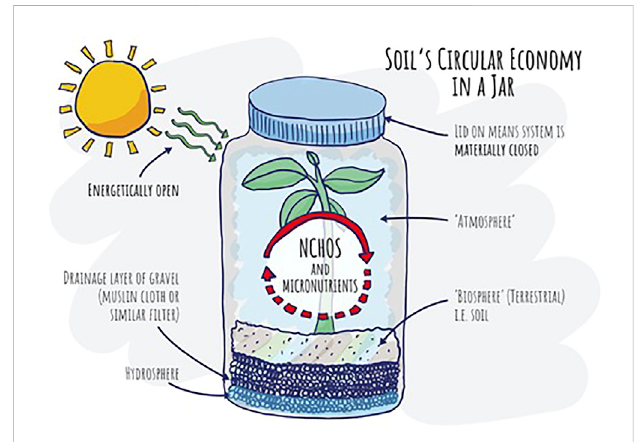
FIGURE 6 Soil in a jar or a terrarium. Building a terrarium using real soil will allow children to understand the links between soil health, plant health, human health and planetary health. Taken from Johnson et al